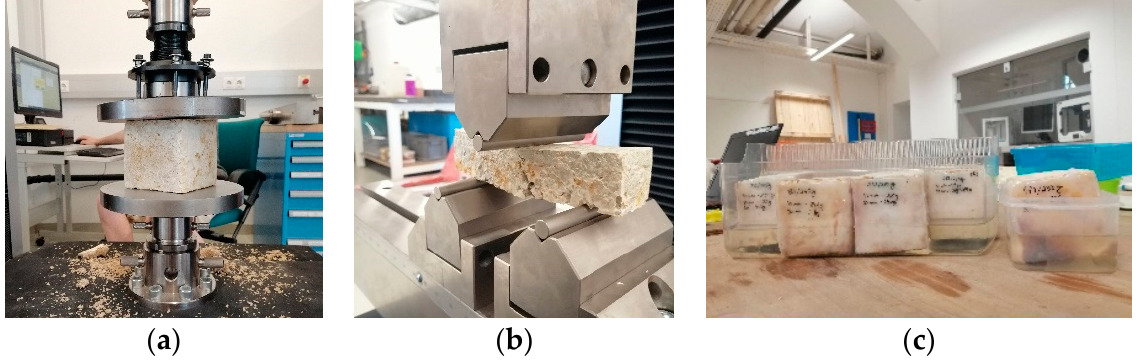
Figure 4. Setup for mechanical material testing and capillary water absorption: ( a ) compression strength; ( b ) three-point flexural test; ( c ) capillary water absorption.